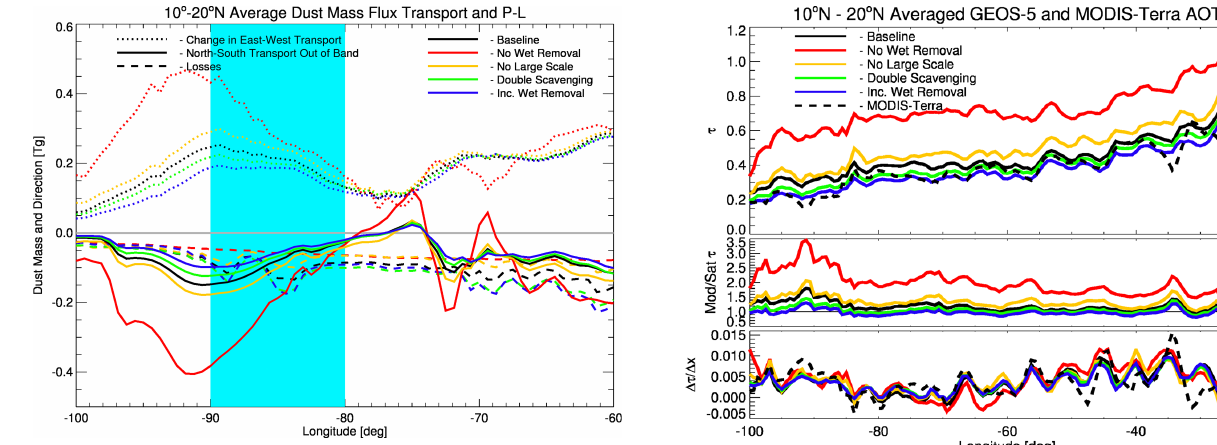
Fig. 15. 10 ◦ N–20 ◦ N averaged AOT, model to satellite AOT ra- tio, and AOT slope for MODIS-Terra and sampled baseline, no wet removal, no large-scale scavenging, doubled scavenging, and wet removal treated as other aerosols sensitivity tests. The thin black line indicates the one-to-one line for ratio